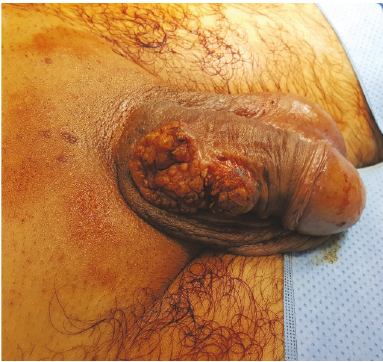
Figure 1: A large exophytic, cauliflower-like, and partially ulcerated lesion, measuring 7x4 cm located at the dorsal surface of the penile shaft.